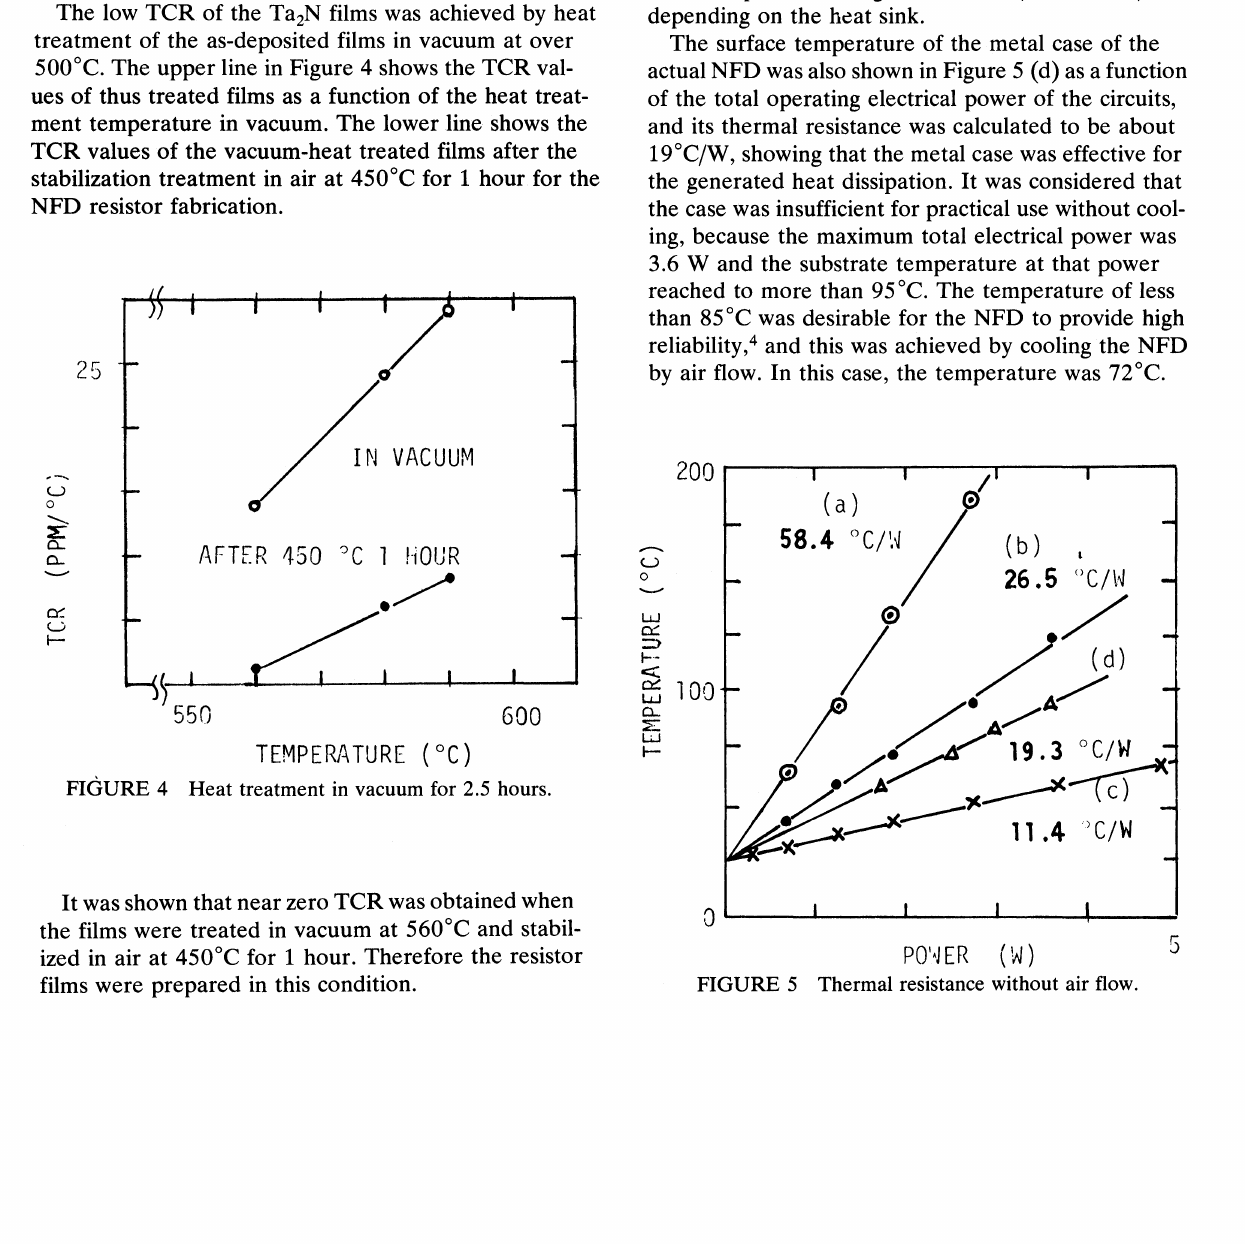
FIGURE 4 Heat treatment in vacuum for 2.5 hours.